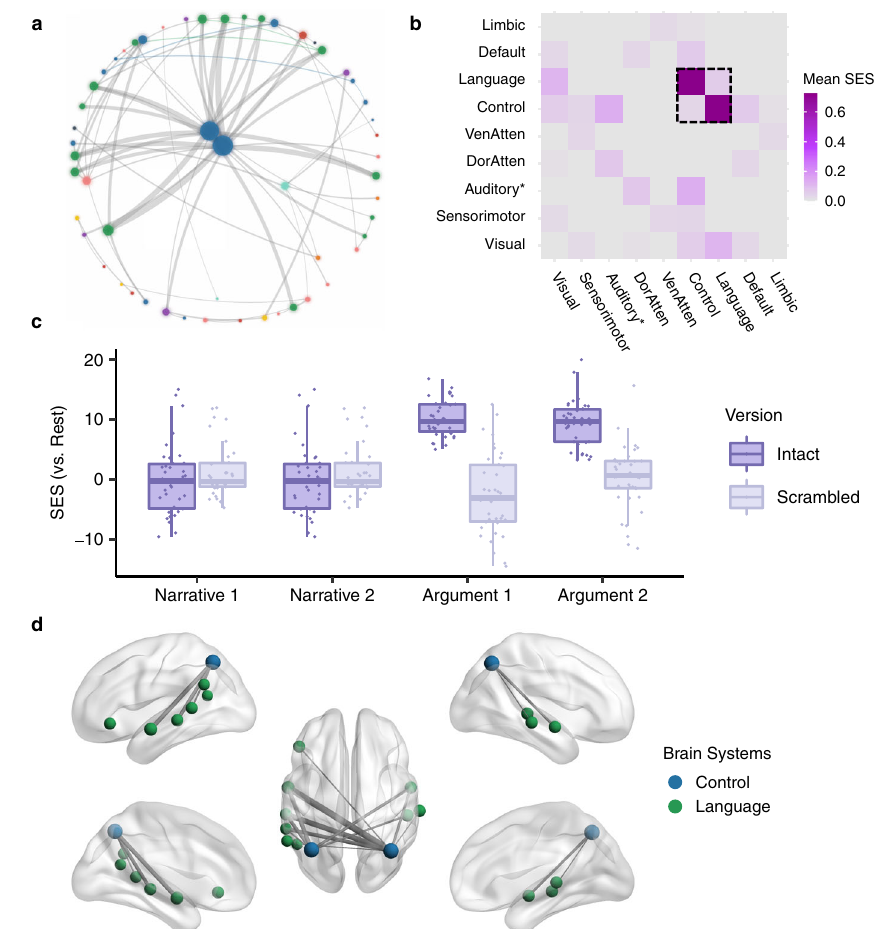
Fig. 9 The brain network speci fi c to argumentative thought. a The network layout of the brain network speci fi c to argumentative thought using the force- directed graph drawing algorithm. It consisted of 78 edges. The color legend is the same as the one in Figs. 4, 5. b The distribution of 78 edges within and between brain systems, where each cell indicates the mean standardized effect size (SES) in the contrast between the intact- and the scrambled- argumentative conditions, i.e., the ratio of the sum of the SES to the number of the edges in the fully connected situation. As highlighted in the dotted box, most of the signi fi cant edges were within the control and the language systems. c The SES of the edges of all the conditions in contrast to the resting state within the control and the language systems. d The top 20 edges with the largest SES in the contrast between the intact- and the scrambled-argumentative conditions in the control and the language systems. In a , d the size of the nodes denotes the node degree of each brain area in the whole graph comprising 78 edges. The color of the nodes denotes to which brain system they belong. The width of the edges denotes the SES. Intra-system edges are in the color of that network; inter-system edges are in